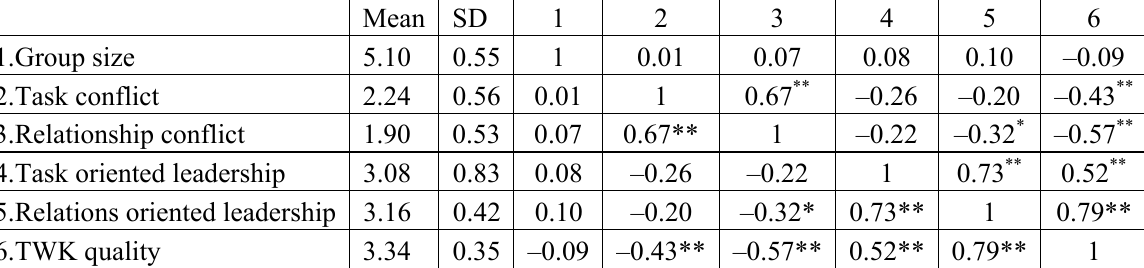
Table 2. Means, standard deviations and